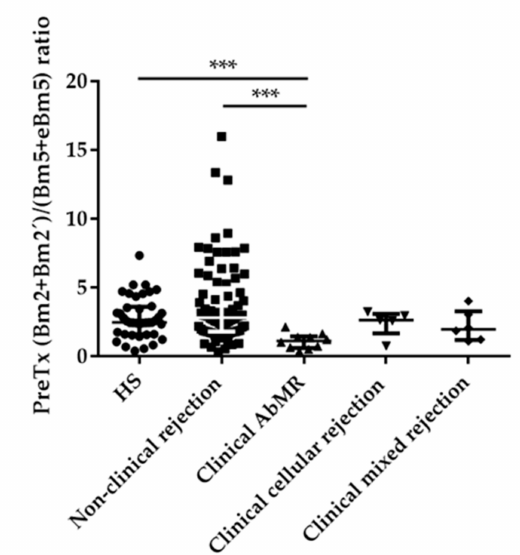
Figure 5. Predominance of pretransplant memory B cells subpopulations (Bm5 + eBm5) in antibody-mediated rejection (AbMR; n = 11) in comparison with non-rejection group ( n = 87) and healthy subjects (HS; n = 40). *** indicates p <